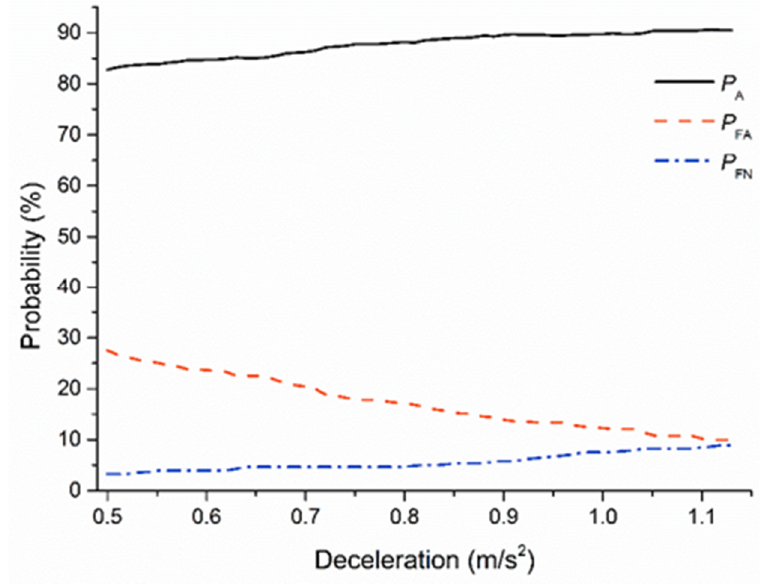
Figure 11. Signal Detection Theory (SDT) for the primary safe threshold (ST 1 ).